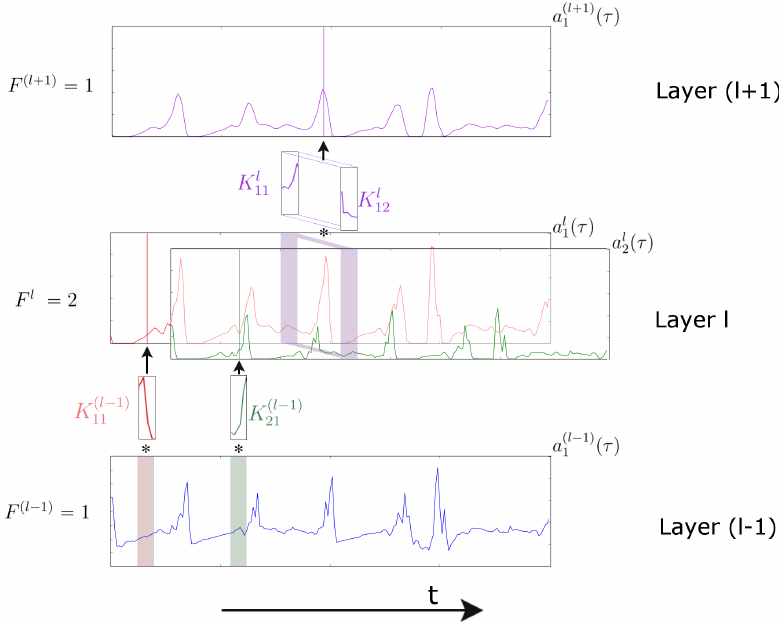
Figure 2. Representation of a temporal convolution over a single sensor channel in a three-layer convolutional neural network (CNN). Layer p l ´ 1 q defines the sensor data at the input. The next p τ q and a l p τ q ) extracted by two different kernels ( K p l ´ 1 q layer ( l ) is composed of two feature maps ( a l 2 1 11 and K p l ´ 1 q ). The deepest layer (layer p l ` 1 q ) is composed by a single feature map, resulting from 21 temporal convolution in layer l of a two-dimensional kernel K l . The time axis (which is convolved 1 over) is